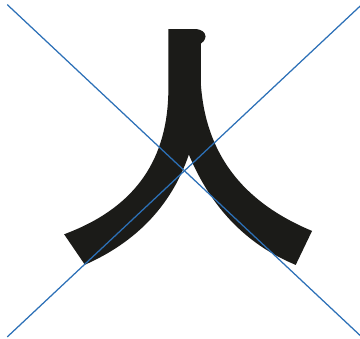
Figure 1: Diagonal intersection stroke density feature extraction.